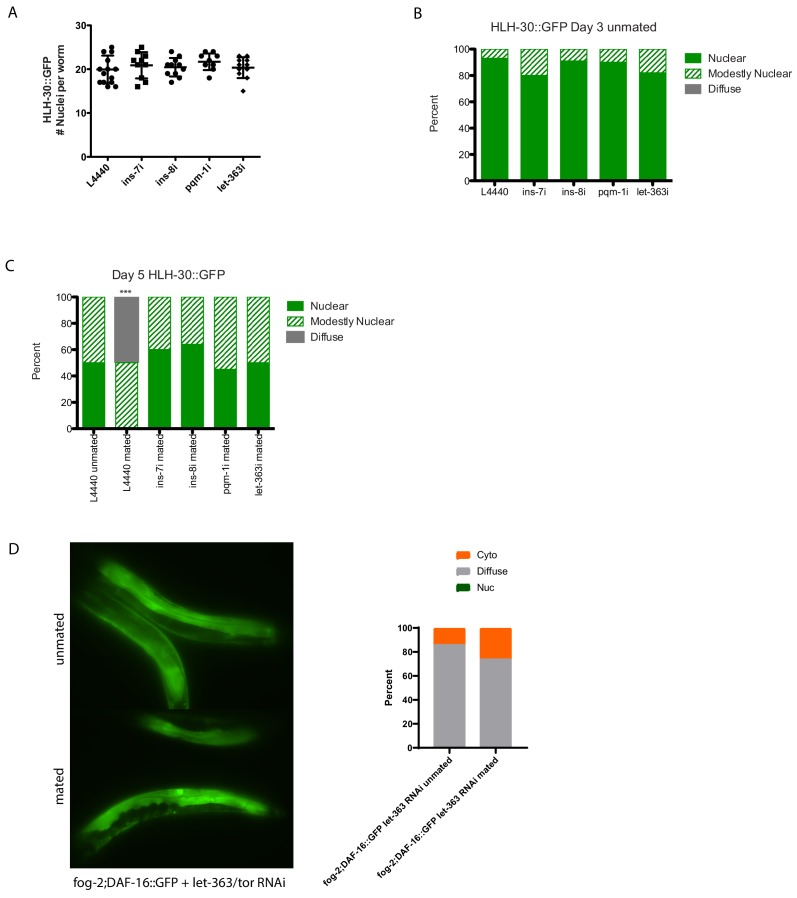
Insulin and mTOR signaling pathways influence HLH-30 and DAF-16 localization in mated hermaphrodites.(A–B) Knocking down pqm-1, insulins, and Tor/let-363 does not affect HLH-30::GFP localization in unmated worms; (C) By contrast, knocking down pqm-1, ins-7, ins-8, or let-363 largely prevent HLH-30::GFP from localizing to the cytoplasm. (D) Mating-induced DAF-16::GFP localization movement was inhibited in fog-2 after knocking down let-363. (in contrast to Figure 2B–C) .